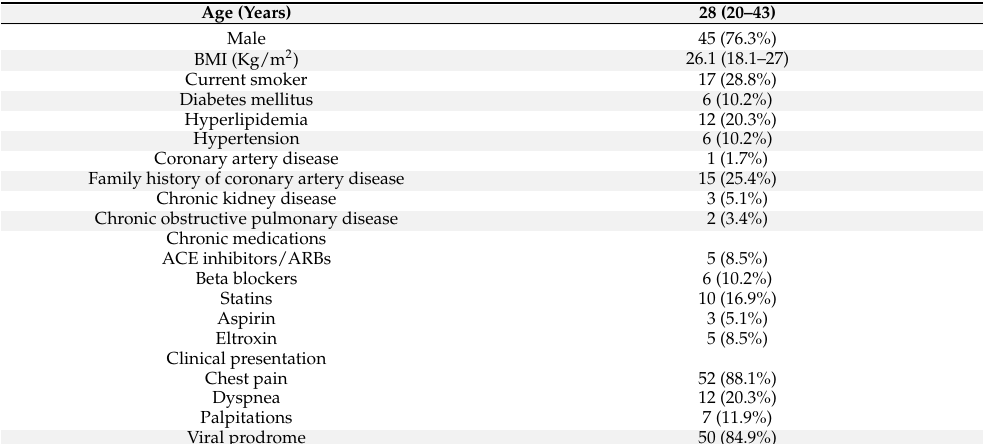
Table 1. Basic characteristics of the study